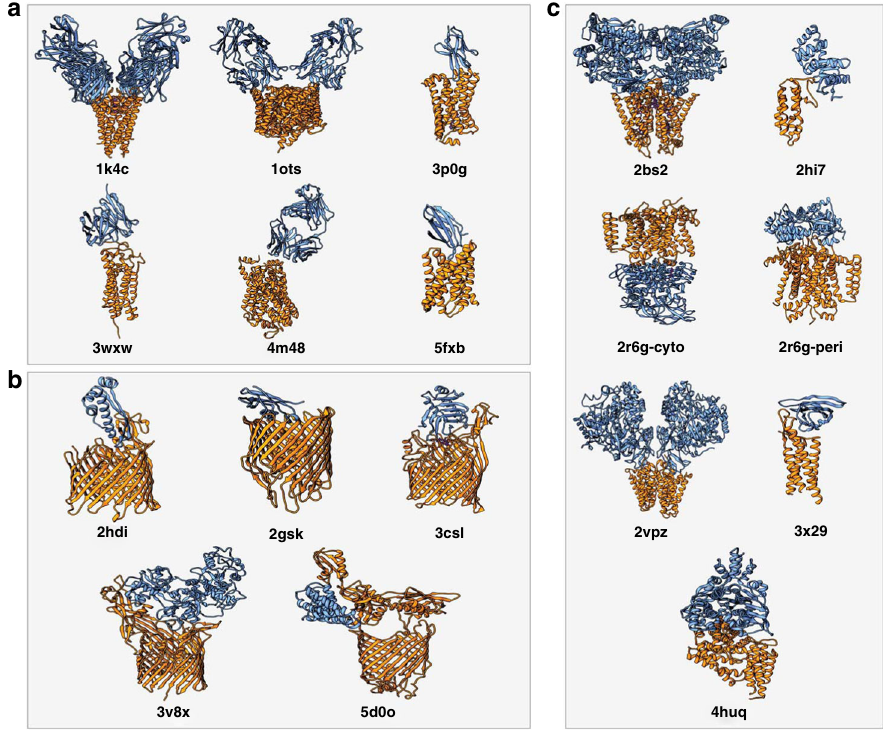
Fig. 2 View of the 18 transmembrane-soluble protein complexes of the MemCplxDB database 38 . The cases are classi fi ed as: a Antibodies (the soluble partner is either an antibody or a nanobody), b β -Barrel (the transmembrane receptor is a β -sheet barrel) and c α -Helical (the transmembrane receptor consists of a bundle of α -helices). The receptors (the membrane proteins) are depicted in orange and the ligands in blue. Unbound initial structures of the 18 cases tested in this work can be found at